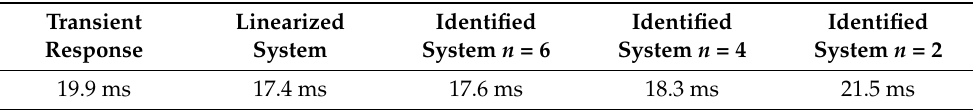
read from the output signal and placement of the